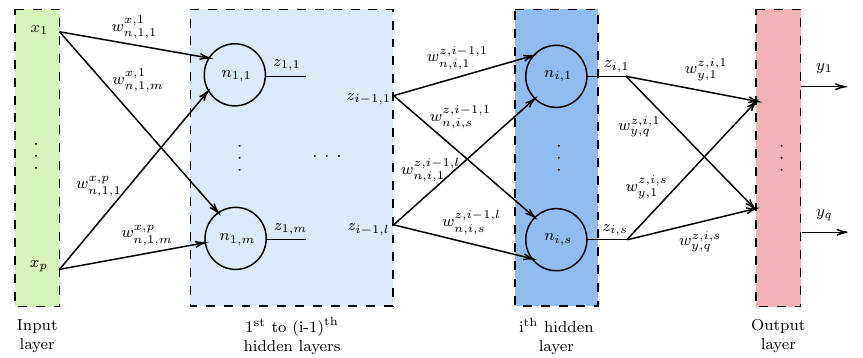
Figure 7. Diagram of fully-connected feed-forward neural network. Table 3. Description of symbols of FC-FNN in Figure